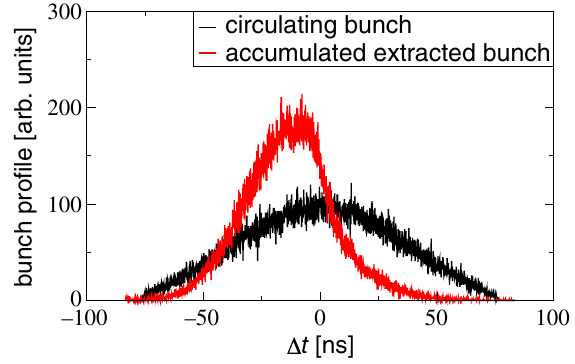
FIG. 3. Intensity profiles as a function of the time difference to the synchronous particle of a circulating bunch and the sum of all bunches extracted during the whole extraction process. In doing so, an accumulated extracted bunch profile is obtained which represents the same particle number as the profile of the circulating bunch. The profiles are obtained in a simulation for ¼ 6 . 2 conditions used in Fig. 1 with h ¼ 5 and V rf